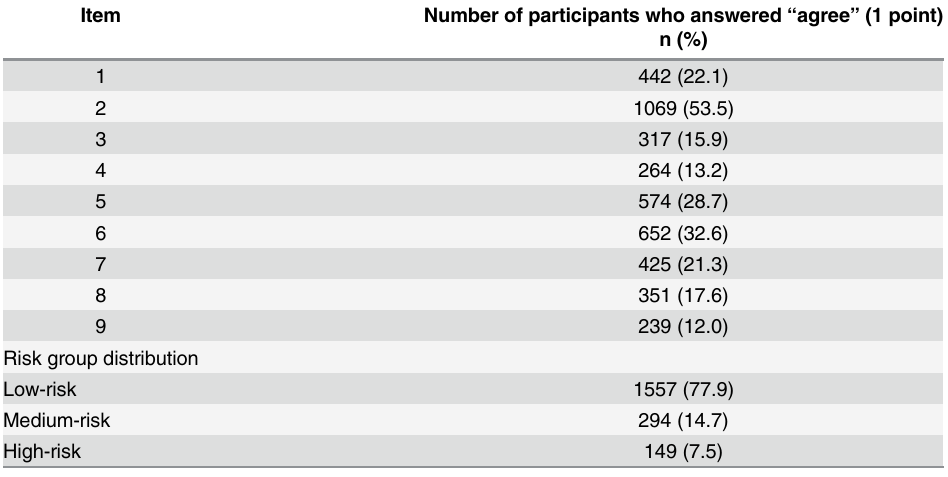
Table 2. Score distribution of STarT-J items and risk group distribution (n = 2000).